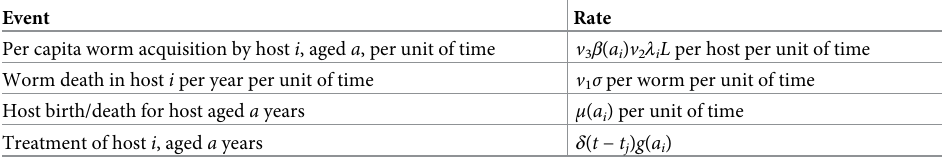
Table 1. Table of events for the stochastic model (as in [16]), where λ i is the gamma distribution for individual i , δ () is the Dirac delta function and g is the proportion treated.